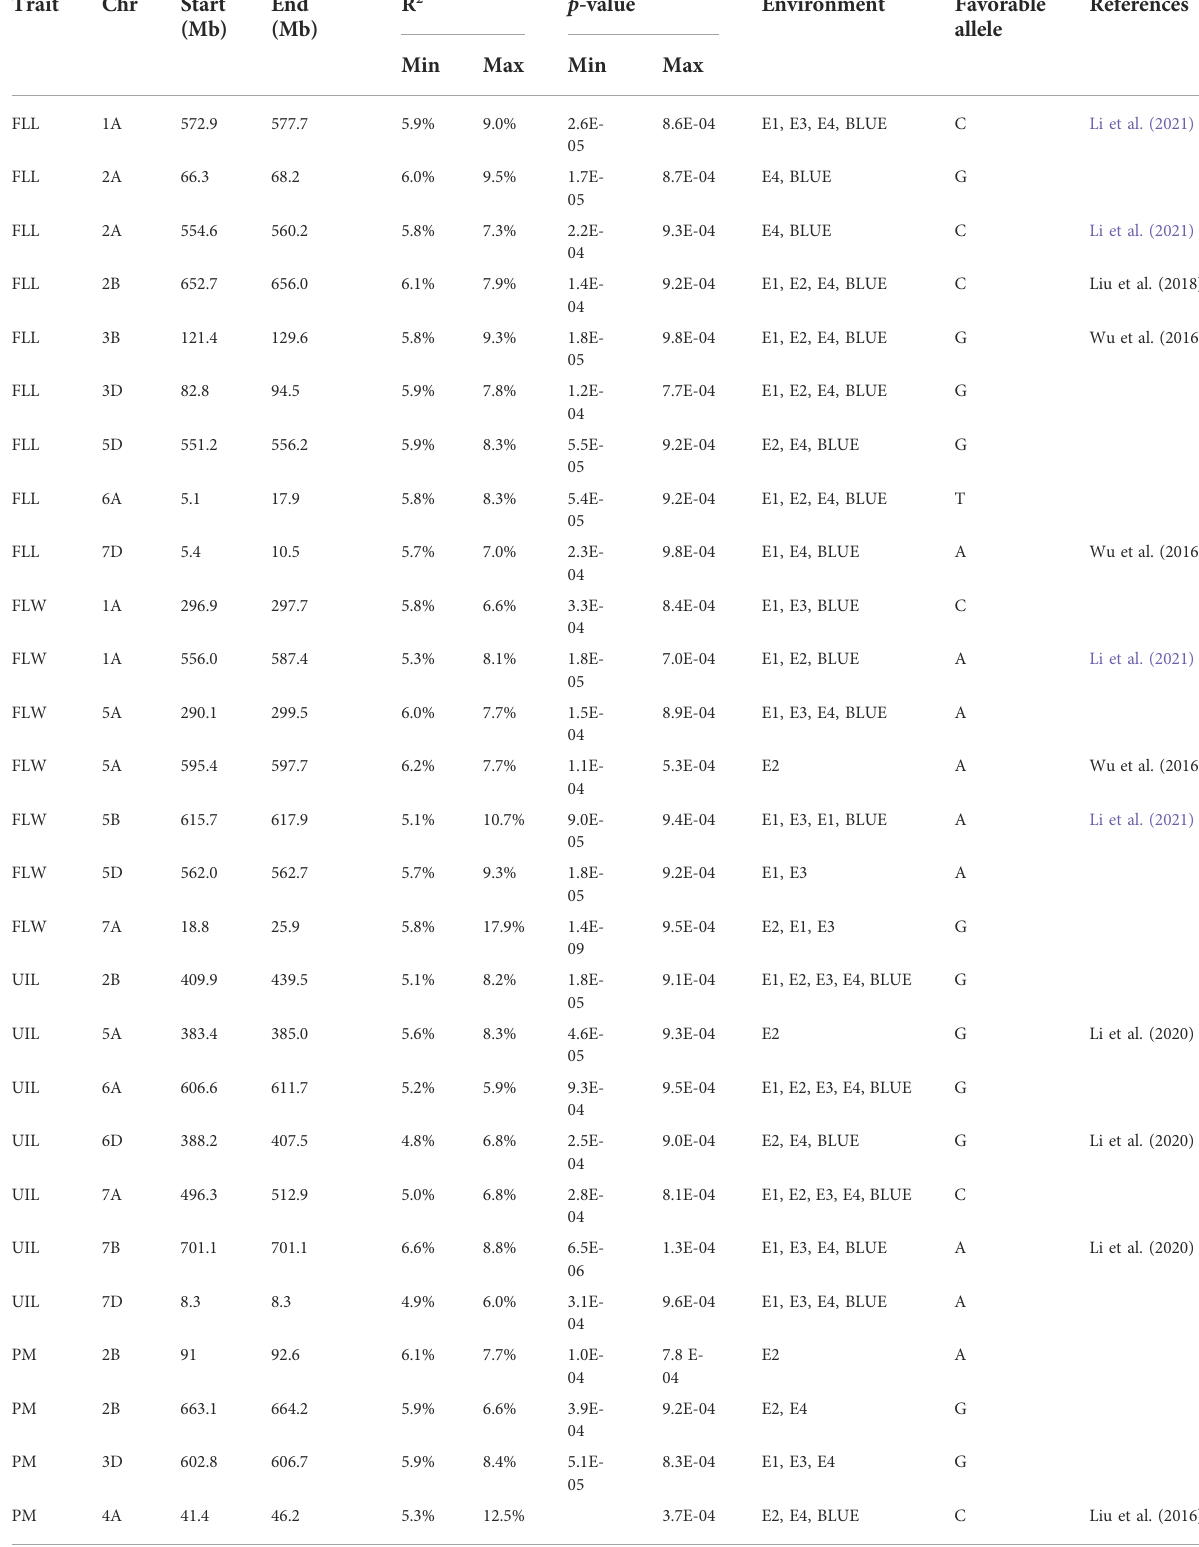
TABLE 2 Loci for morphological traits in 251 spring wheat accessions from the Northeast of China by association analysis. Trait Chr Start R 2 p (Mb)